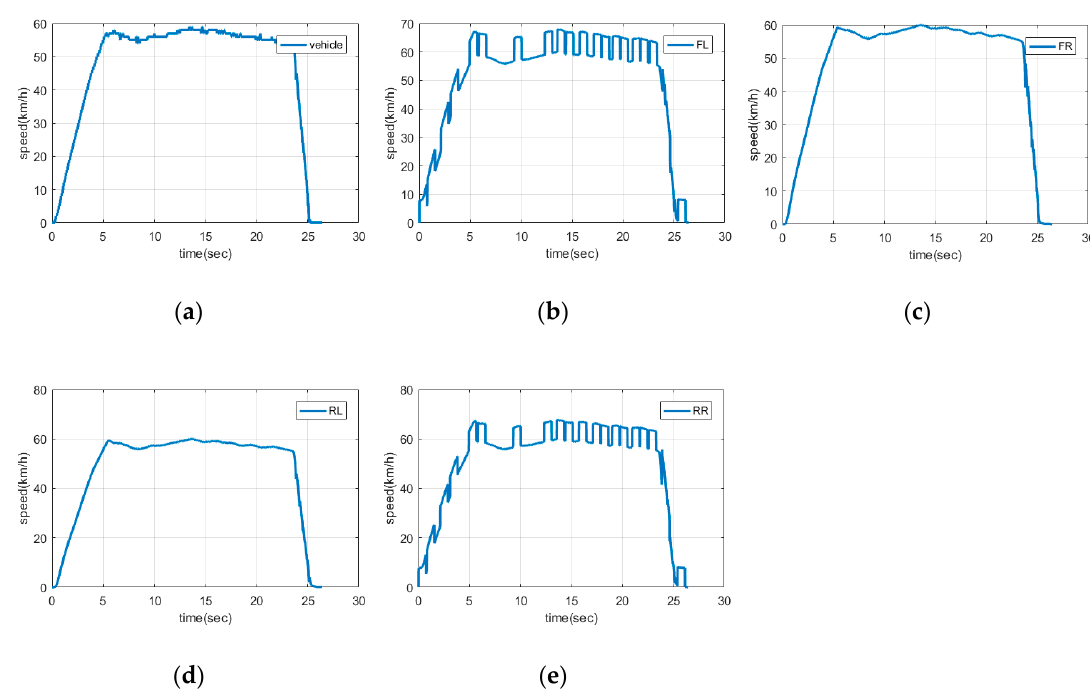
Figure 1. Class 7 training dataset: ( a ) Vehicle speed; ( b ) Front left wheel speed; ( c ) Front right wheel speed; ( d ) Rear left wheel speed; ( e ) Rear right wheel speed.